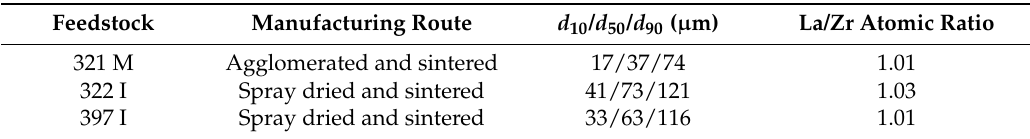
Table 1. Lanthanum zirconate (LZ) feedstock powder